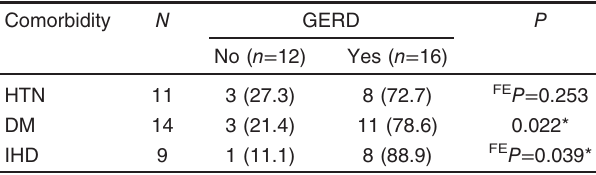
Results are presented as number and percentage. DM, diabetes mellitus; FE, Fisher ’ s exact test; HTN, hypertension; IHD, ischemic heart disease. * P ≤ 0.05, statistically significant. Table 8 Relation between gastroesophageal reflux disease and Helicobacter pylori infection H. pylori